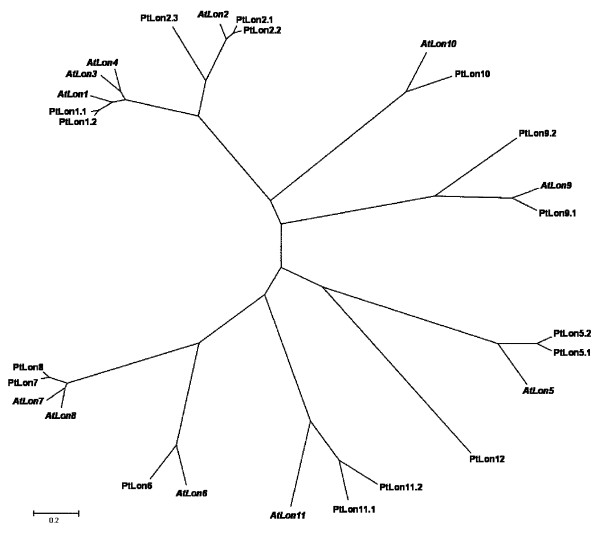
UPGMA (Unweighted Pair Group Method with Arithmetic Mean) tree of the Lon protease family (S16 family in MEROPS). The names and the accession numbers for the different proteins are given in Table 5.